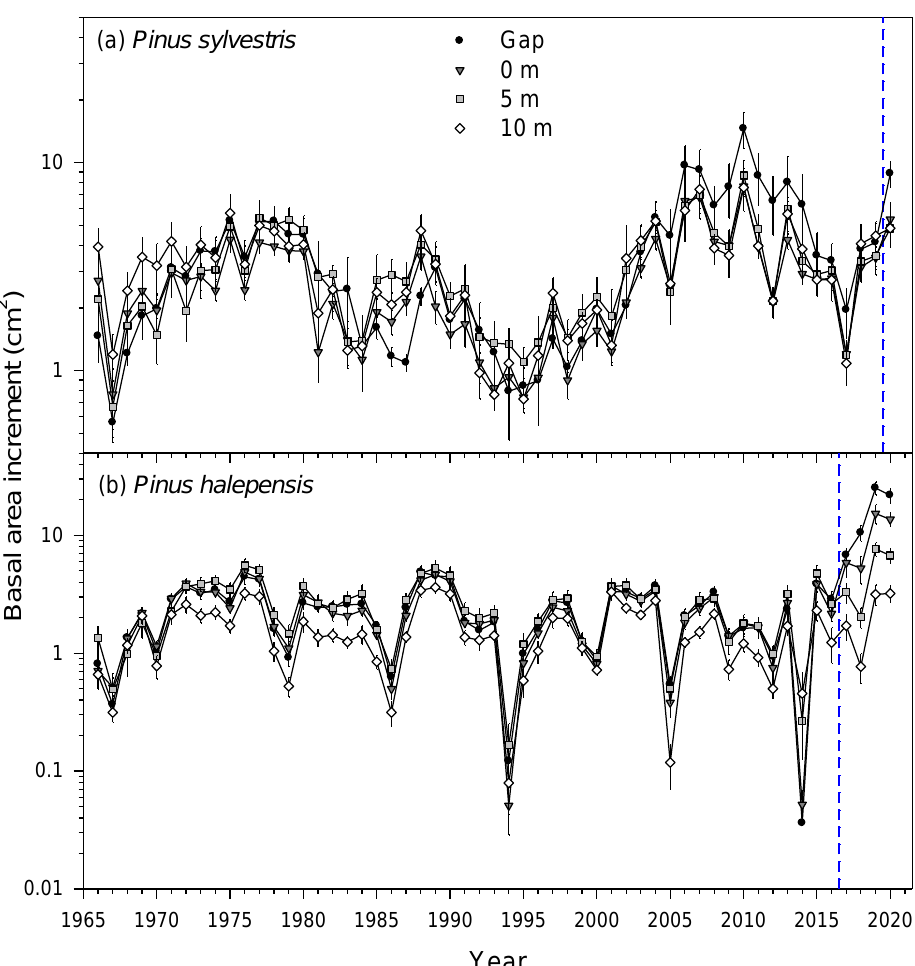
Figure 2. Growth data (basal area increment) of the affected ( a ) Pinus sylvestris and ( b ) Pinus halepensis stands. The symbols indicate trees sampled within the gap or located at 0, 5 and 10 m from the gap edge. The dashed vertical lines indicate the change in growth after the storm impacts. Values are means ± SE. Nothe the logarithmic scales.